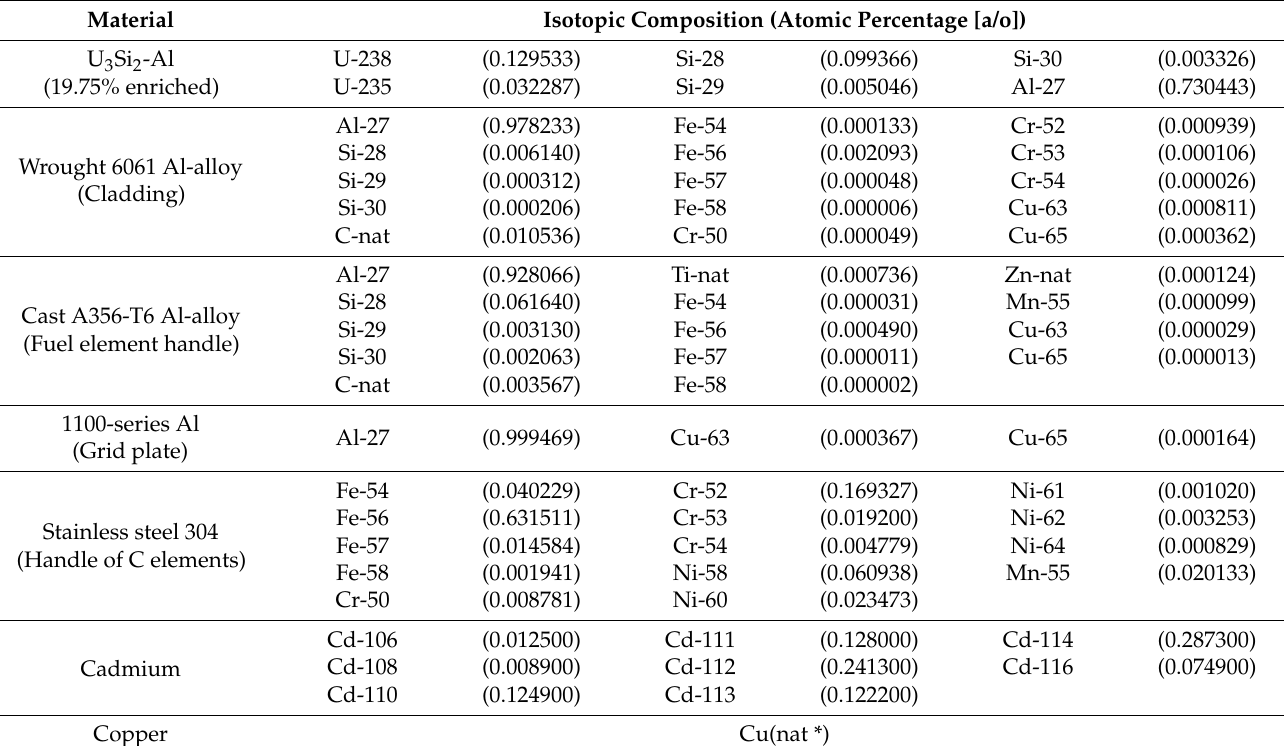
Table 1. Material composition used in the OpenMC model.